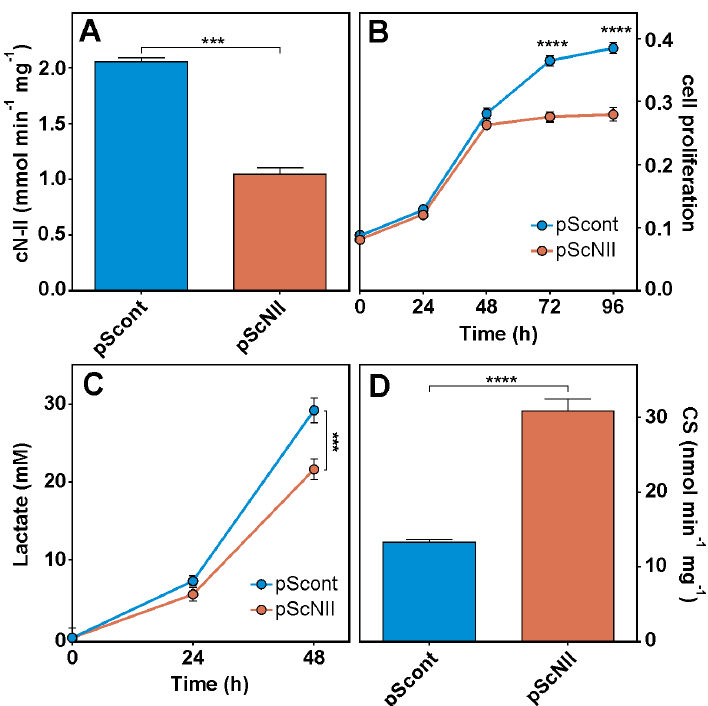
Figure 8. Effect of cN-II silencing in ADF cells. ( A ) cN-II activity in pScont and pScNII; ( B ) ADF pScont and pScNII cell growth; ( C ) lactate level at 24 and 48 h of growth; ( D ) CS activity. The assays were performed as described in Materials and Methods. The results are the mean + SEM of three independent experiments. *** p < 0.001, **** p < 0.0001.